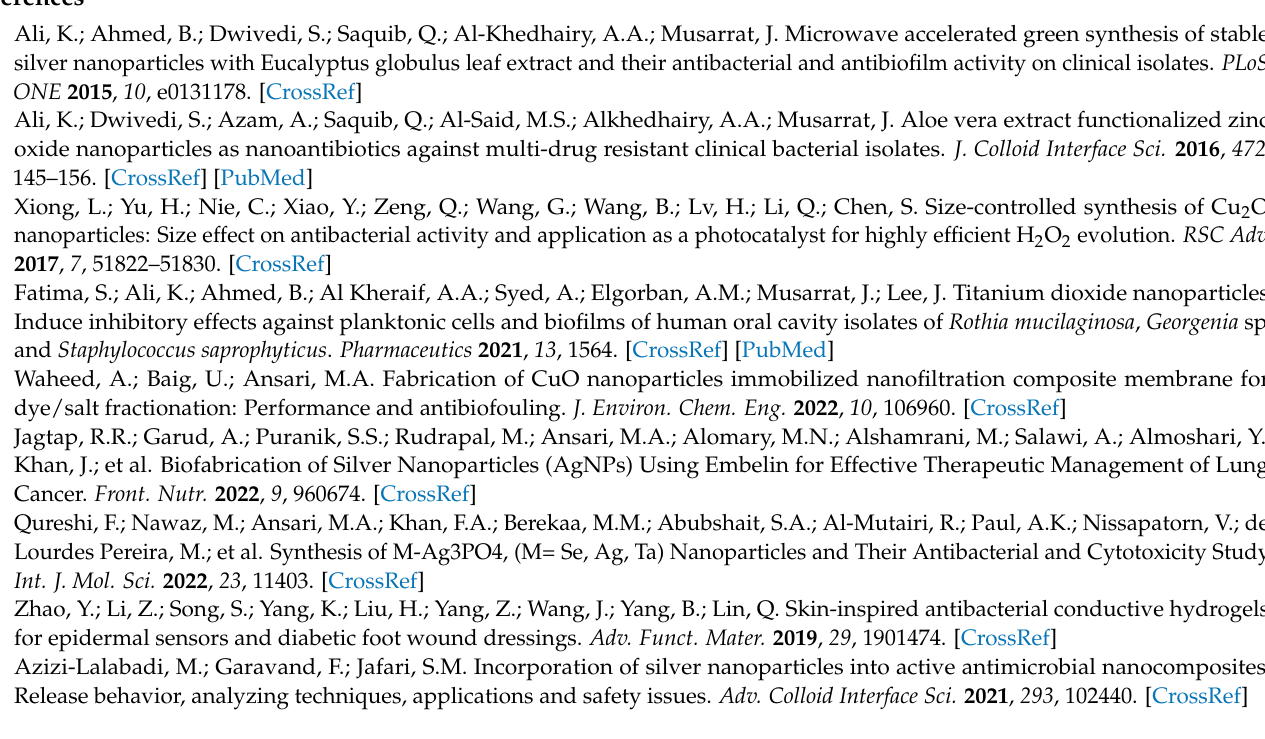
Figure S3: Elemental mapping